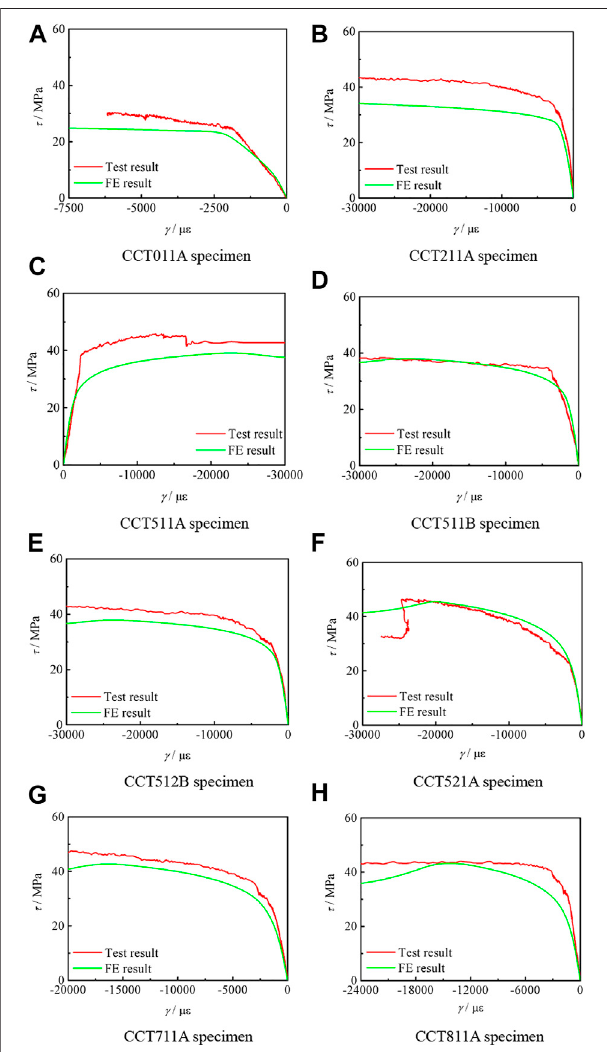
FIGURE 14 | Comparison between τ – γ curve simulation results and test results of compression torsion specimens. (A – H) Different curves between Test and FE